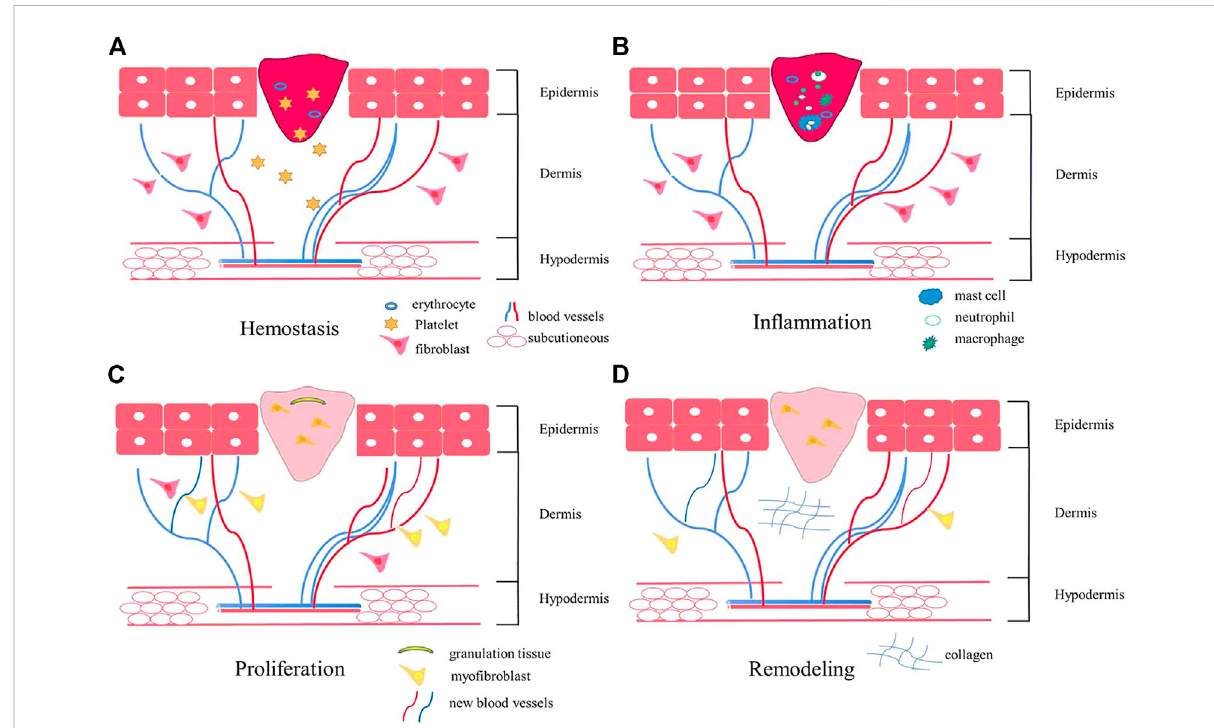
FIGURE 1 The schematic diagram of the wound healing process. Wound healing includes four stages: hemostasis (A) , in fl ammation (B) , proliferation (C) , andremodeling (D) .Aftertheinjury,plateletsaggregateandreleasesolublemediatoinitiatehemostasis.Shortlythereafter,in fl ammationbegins,and macrophages accumulate and migrate to the wound, promoting phagocytosis of bacteria and injuring tissues. Angiogenesis occurs at the proliferation stage. In the fi nal remodeling stage, wound tensile strength